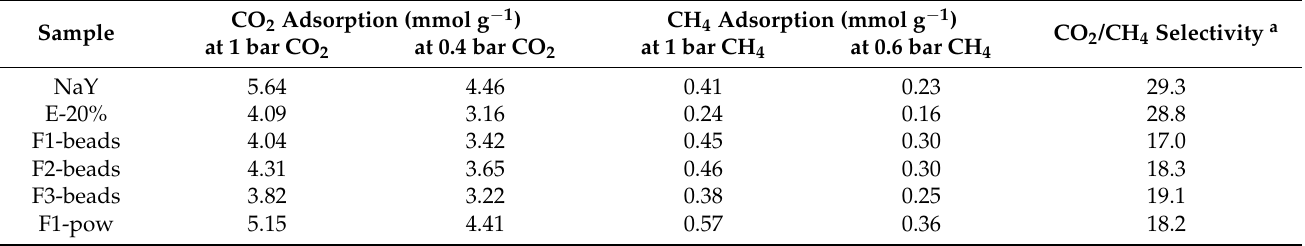
Figure 6. CO 2 (black) and CH 4 (red) adsorption isotherms of F1-beads–F3-beads, F1-pow, commercial zeolite Y powder (NaY), and extrudates from commercial zeolite Y with 20 wt% binder (E-20%). Table 3. CO 2 and CH 4 adsorption capacity and CO 2 /CH 4 selectivity for all the studied